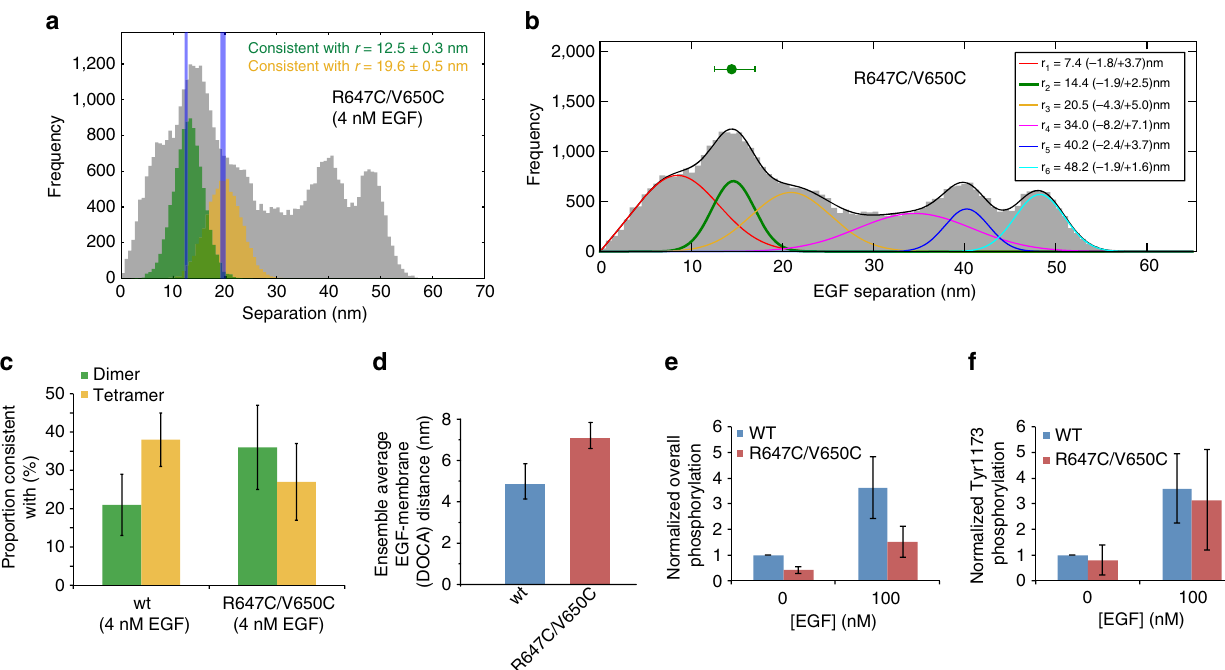
Figure 5 | Pairwise EGF separations and phosphorylation of R647C/V650C. ( a ) FLImP distribution (grey) of pairwise EGF separations on CHO cells expressing the R647C/V650C-EGFR mutant at a level of B 10 5 copies per cell. The separations whose confidence intervals overlap with the 12.5 ± 0.3nm (green) or 19.6 ± 0.5nm (yellow) expected dimer and tetramer interval are shown. The expected intervals are indicated by the vertical blue lines. The distribution includes data from 40 FLImP measurements with confidence intervals o 6nm. ( b ) Peak decomposition (colour lines) and best-fit (continuous black line) of the FLImP distribution. The optimal number of underlying peak components (colour lines) and the best-fit (black line) were determined using a Bayesian information criterion. The best-fit positions of the peaks and error bars are shown in the inset. ( c ) Similar to Fig. 3e, an estimate of the relative populations of dimers and tetramers. ( d ) Comparison of EGFR R647C/V650C and the wild-type receptor in terms of DOCA distances between receptor-bound EGF molecules and the membrane at 4nM EGF derived from FRET measurements shown in Supplementary Fig. 8f. ( e ) Overall and ( f ) Tyr1173-specific phosphorylation of EGFR R647C/V650C compared with the wild type at 100nM EGF. The data points and error bars (s.d.) are obtained from three independent measurements. An example is shown Supplementary Fig.